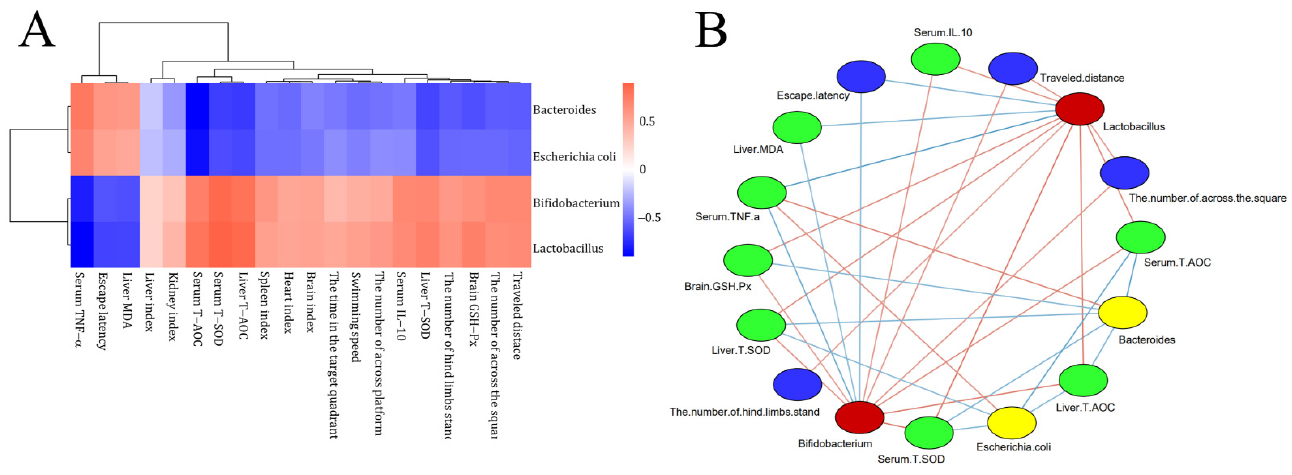
Figure 7. Correlation of gut flora with aging-related parameters: ( A ) Heat map of correlations between key microorganisms and aging-related parameters; ( B ) association network of key microor- ganisms and aging-related parameters. Red nodes: key microorganisms with increased dietary fiber complex intervention; yellow nodes: key microorganisms with decreased dietary fiber complex in- tervention; blue nodes: behavioral indicators; green nodes: biochemical parameters. Red lines indi- cate positive correlations and blue lines indicate negative correlations. Color shades indicate corre- lation strength. Only valid edges were plotted in the network (|r| > 0.6, p < 0.05). 4. Discussion In this study, we found that longevity dietary pattern-mediated CDFC has a bidirec- tional modulatory effect on body weight in naturally aging mice. Body weight is closely related to healthy living in the elderly [26]. Both obesity and underweight can have ad- verse health effects [27]. Previous studies have shown that aging mice suffer from signifi- cant memory loss, weight loss, and decreased organ indices [28,29]. In the present study, we found that mice fed standard chow significantly lost body weight during aging, and CDFC inhibited aging-induced weight loss. Additionally, CDFC attenuated the weight gain caused by dietary fiber-free diets. In contrast, one study found that oligofructose sig- nificantly reduced diet-induced obesity and that the combination of oligofructose and re- sistant starch, or β -glucan, did not reduce obesity [10]. The different results between these studies may be related to the type and amount of dietary fiber as well as individual dif- ferences. In addition, in this study, mice fed standard chow exhibited atrophy of brain, spleen, and heart, while CDFC improved the corresponding organ indices. Notably, the NDF group also exhibited lower organ indices, which may be related to their higher body weight. This suggests that CDFC can delay organ degeneration and improve organ im- munity in mice, and it has a significant anti-aging effect.